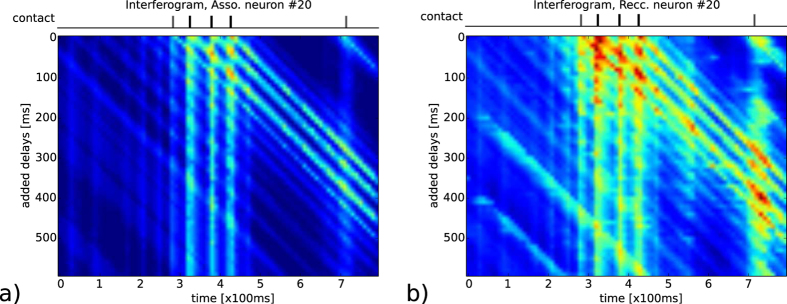
Interference patterns of the neural activity in the associative and recurrent maps for various visual delays of up to 600 ms.In (a), the associative neuron’s activity is weakly sensitive to the interference patterns due to contiguous visuo-tactile activity between the vertical lines (current tactile input) and the diagonals (visual delays). In (b), the recurrent neuron is more sensitive to the visuo-tactile contingency as the activity level increases, although it also discharges in advance or later when strict contingency is not respected (memory effect).